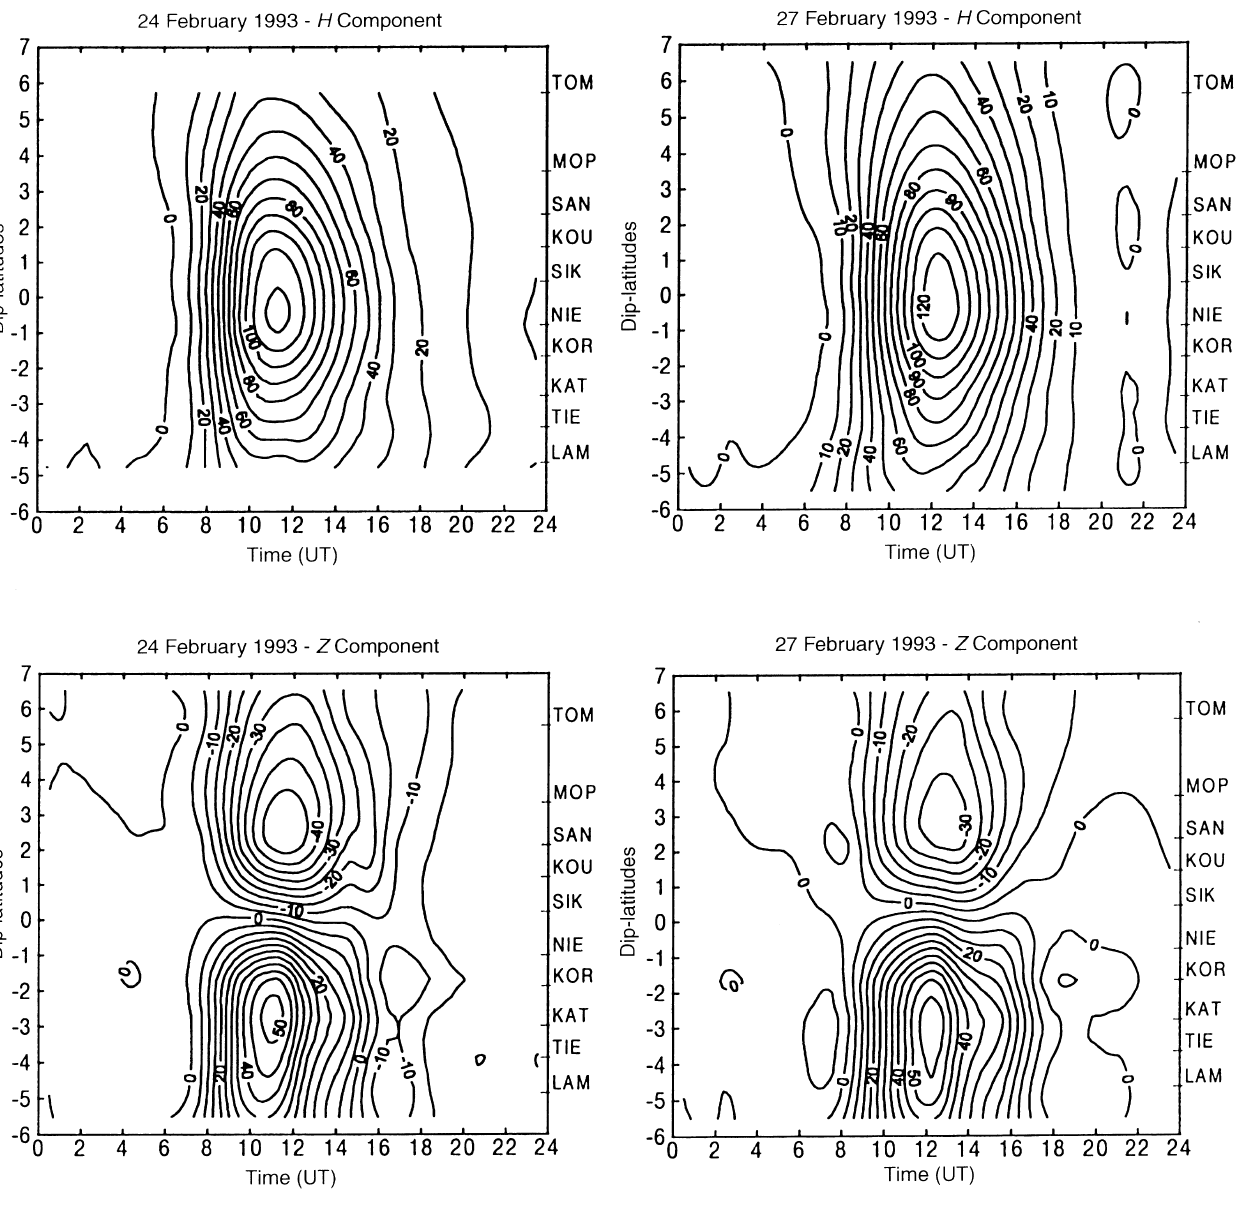
Fig. 6. Contour maps of the horizontal H and vertical Z components of the magnetic field recorded at the stations of the profile, on 24 and 27